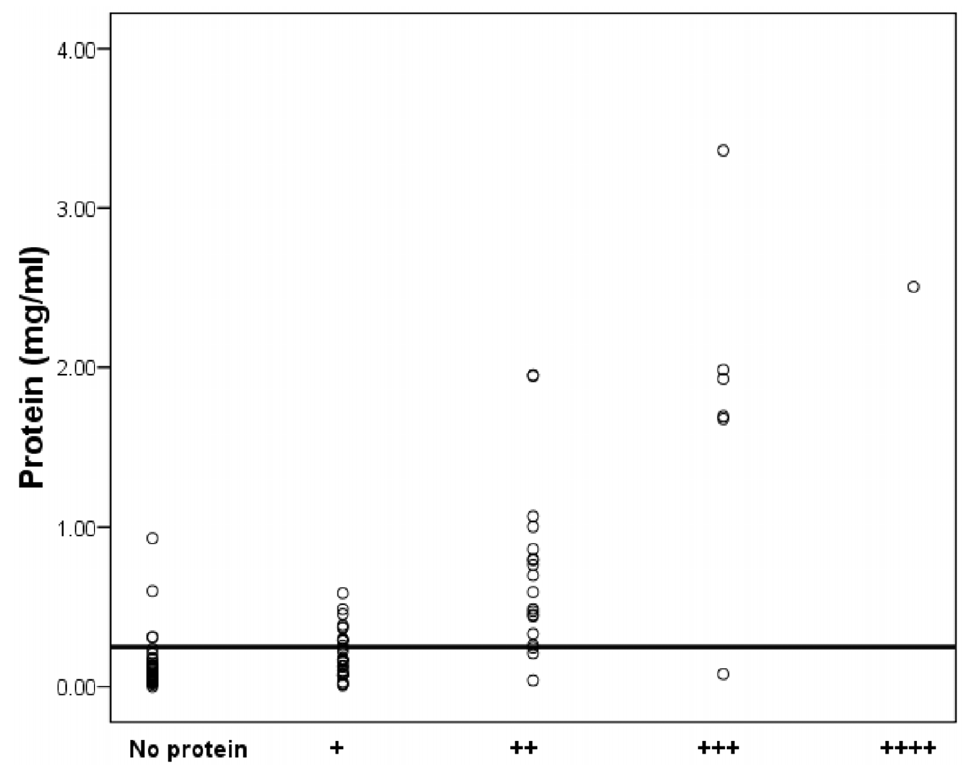
Figure 3. Comparison between measured protein levels and protein dipstick analyses. Total protein levels (mg/ml) in urine were determined by Bradford assay A 595 nm (Hitachi U2800 spectrophotometer) using Bovine Serum Albumin as standard. Dipstick analyses were